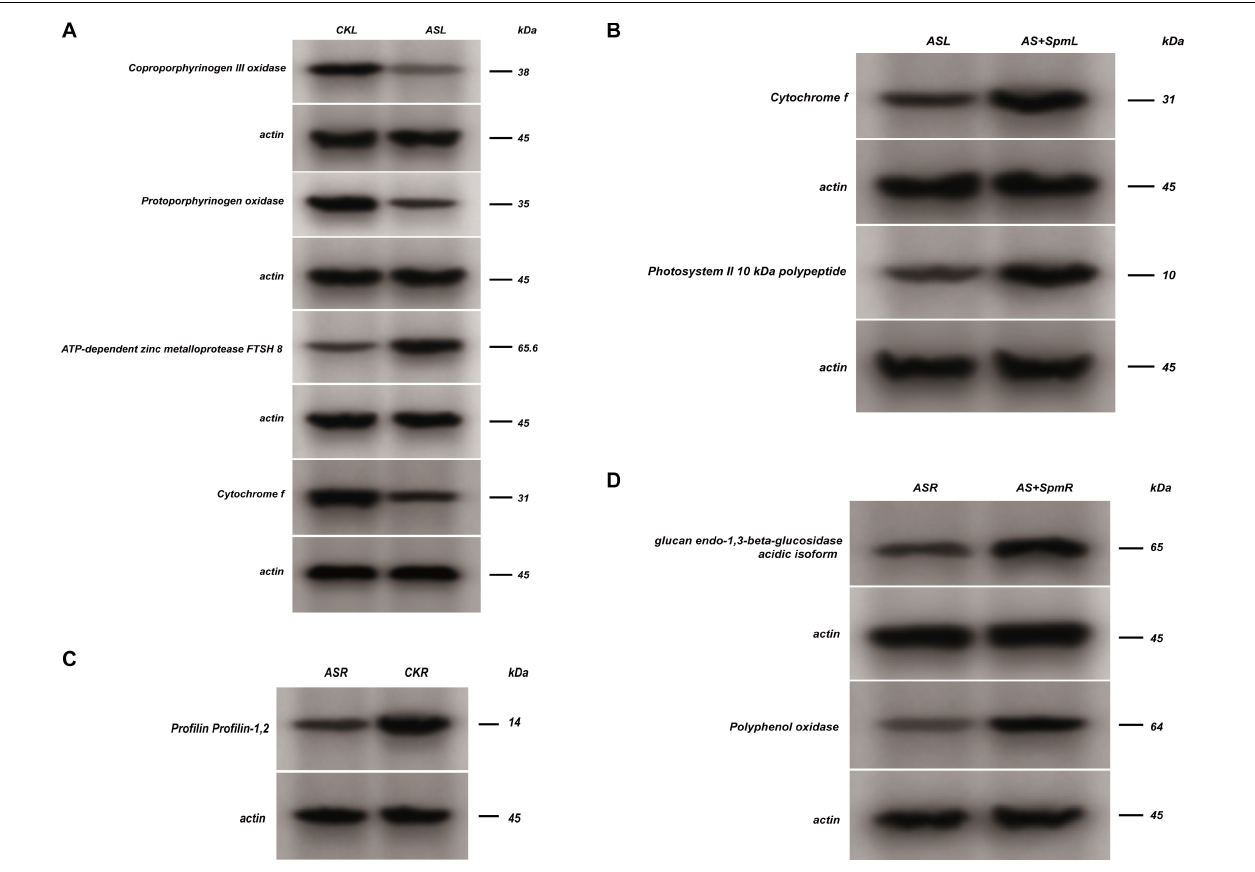
FIGURE 4 | Western blot analysis. CK, control; AS, alkali stress (35 mmol.L − 1 Na 2 CO 3 :NaHCO 3 = 1:1); AS + Spm, alkali stress + spermine (35 mmol.L − 1